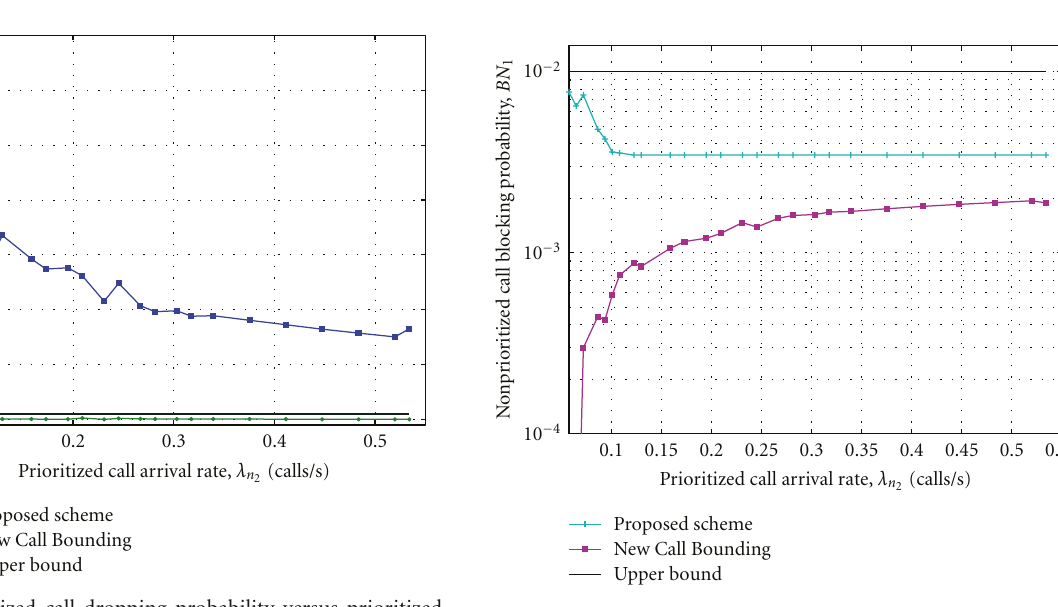
Figure 5: Blocking probability of nonprioritized calls versus prioritized calls arrival